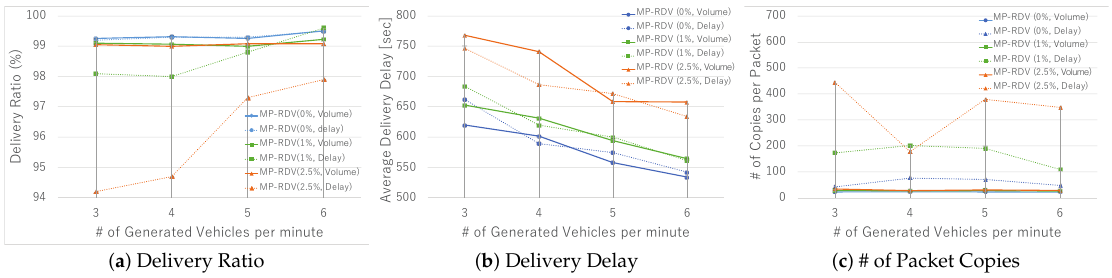
Figure 14. Comparing two routing metrics: delivery ratio, delivery delay, and the number of packet copies are compared with both delay and volume metrics.